Question: What form of chart is displayed?
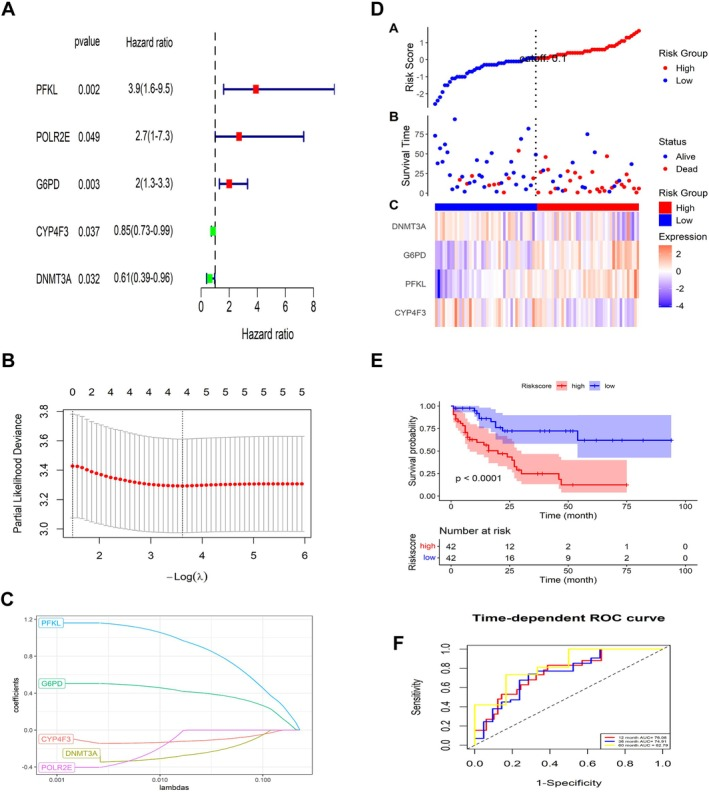
Answer: survival